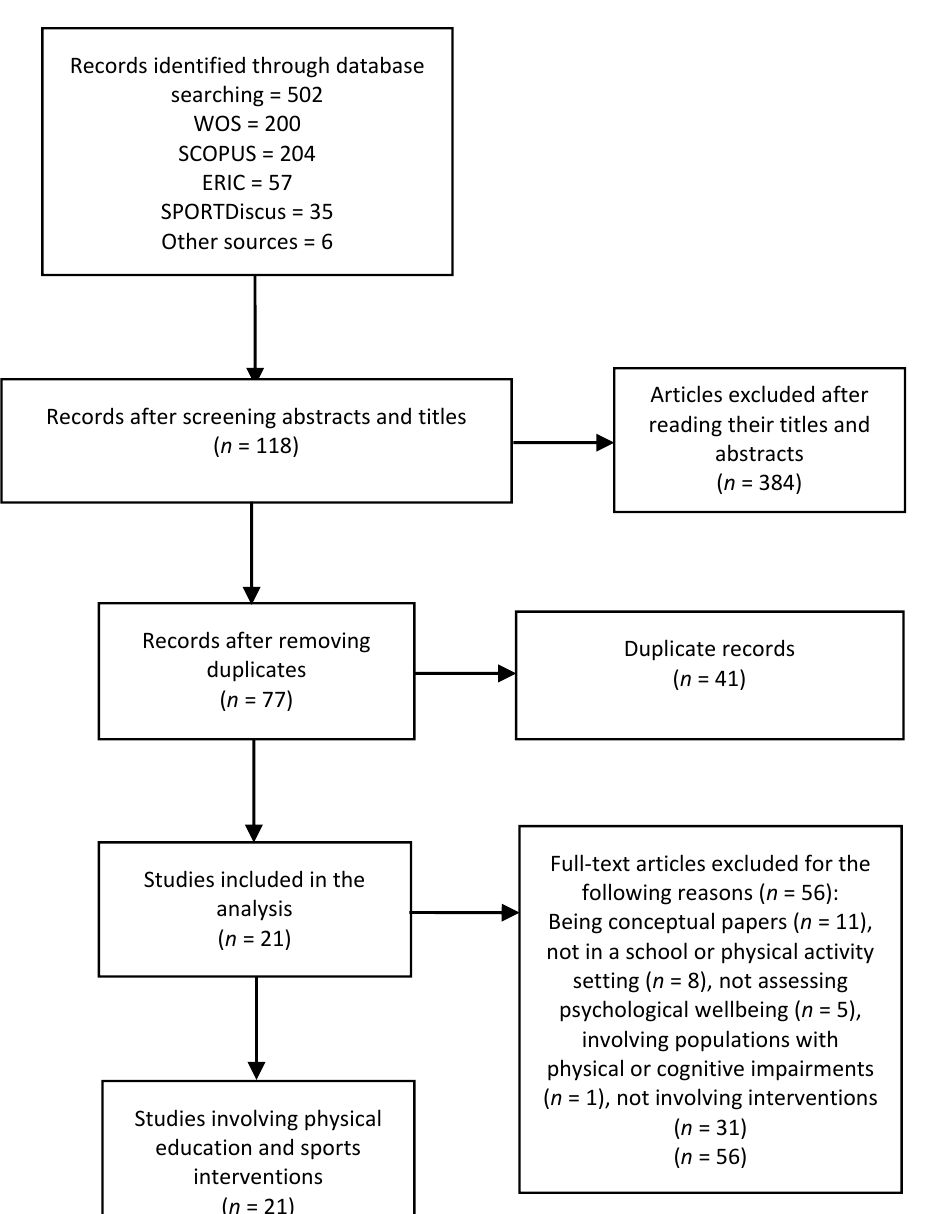
Figure 1. Flow chart of the sampling process.